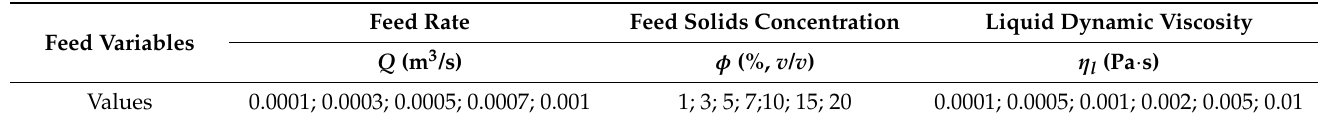
Table 3. Feed parameters tested in the present